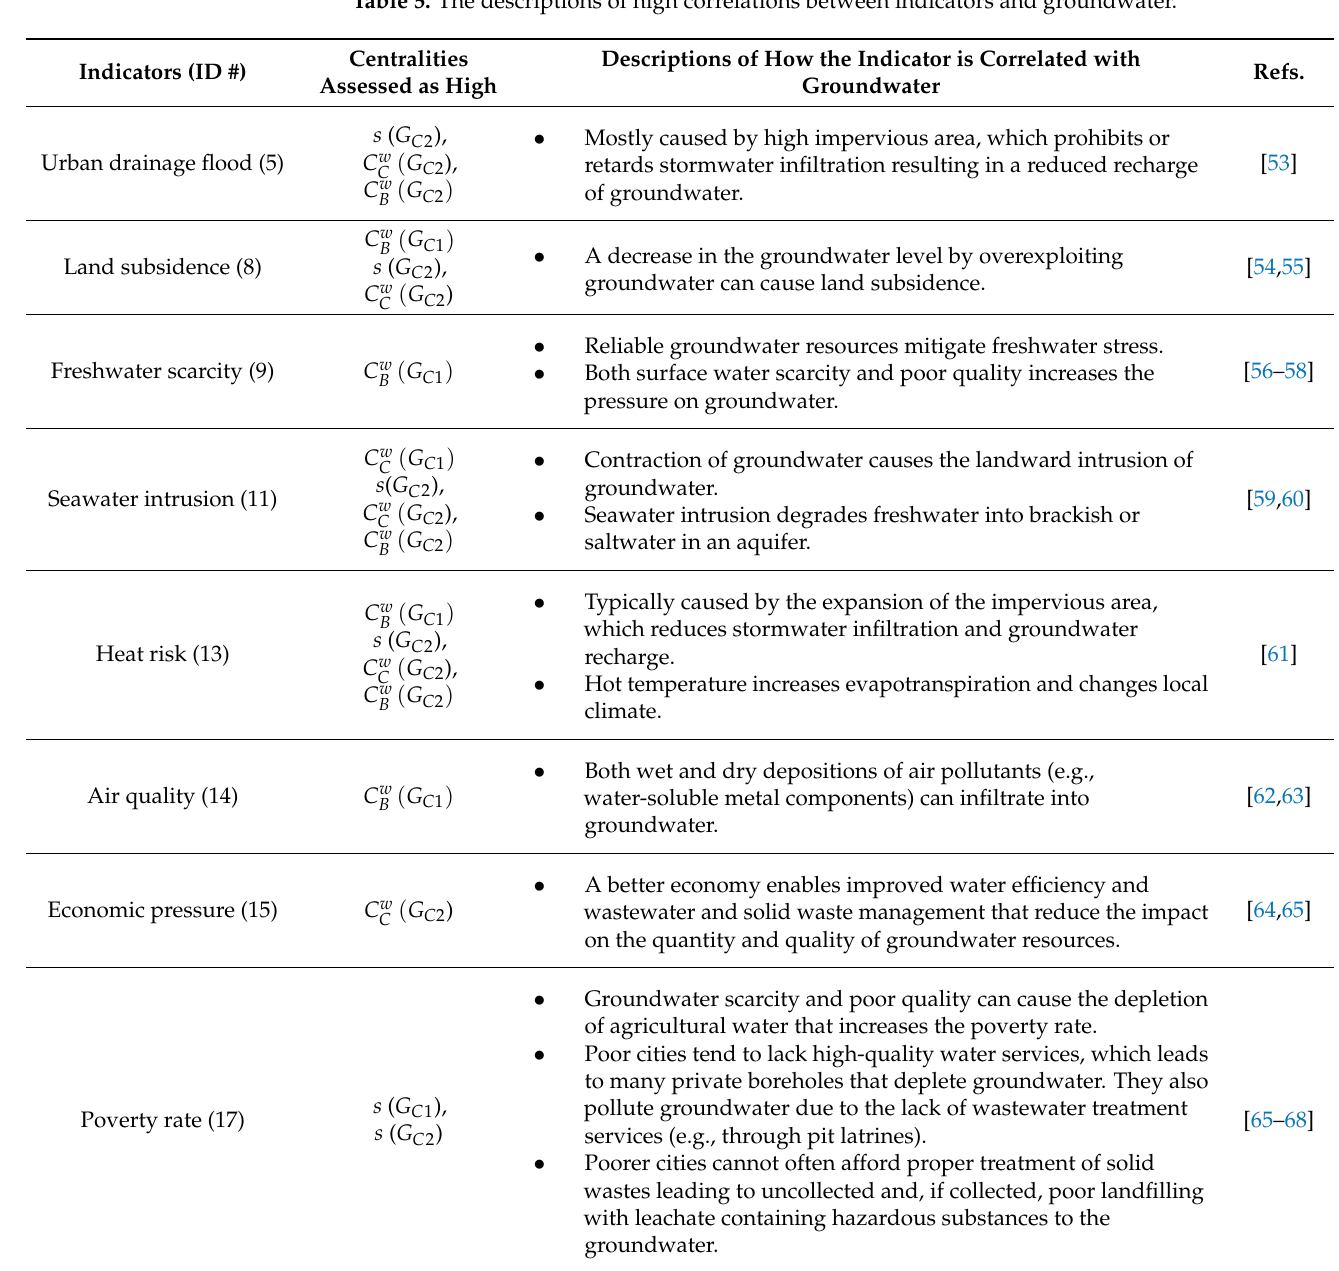
Table 5. The descriptions of high correlations between indicators and